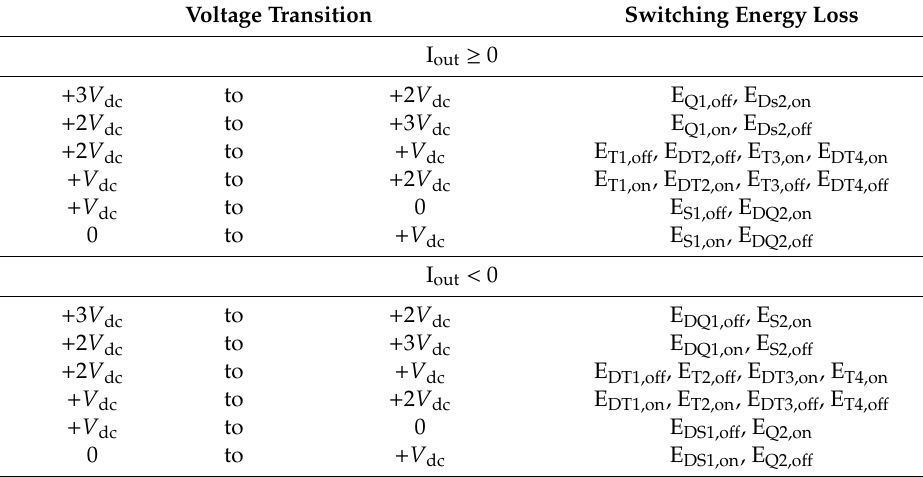
Table 4. Switching energy loss of the phase a components in the proposed 4LT 2 C.